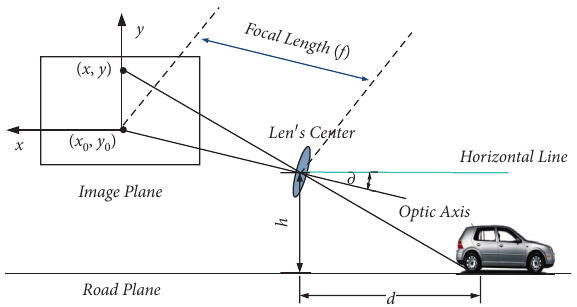
Figure 4: Schematic diagram of the horizontal distance between the object point and the camera.